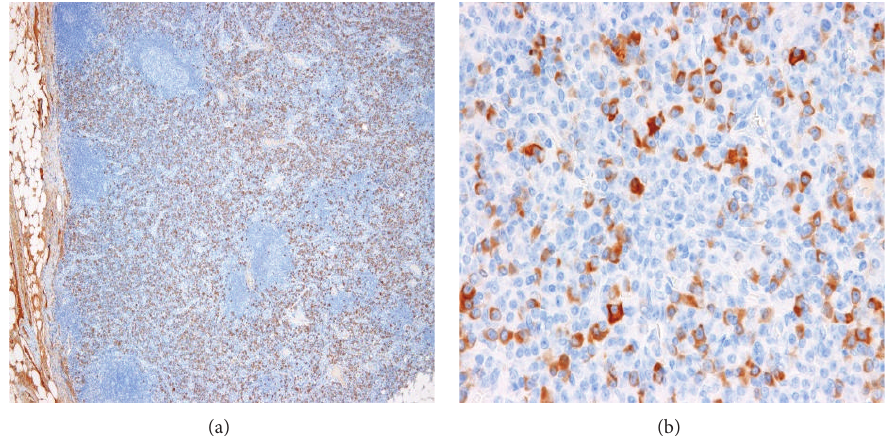
Figure 4: Histopathological findings of the specimen obtained by inguinal lymph node biopsy. IgG4 staining (a, b) revealed IgG4-positive mononuclear cell infiltrates. IgG4/IgG ration was over 90% and more than 300 IgG4-positive plasma cells per high-power field: (a) 4x; (b)